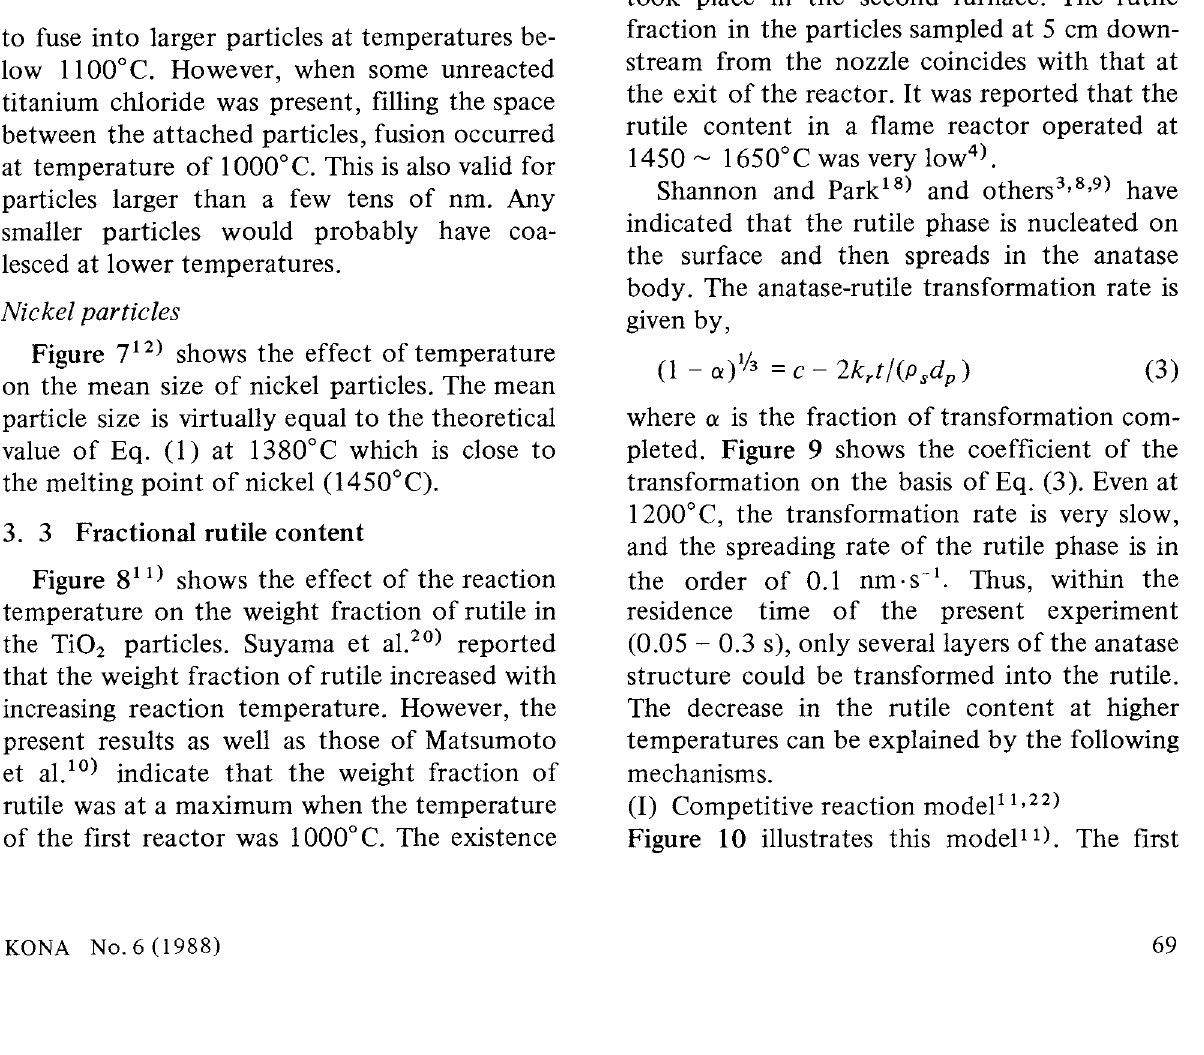
Fig. 8 The effect of 1st furnace temperature on rutile fraction. The experimental conditions are the same as in Fig.